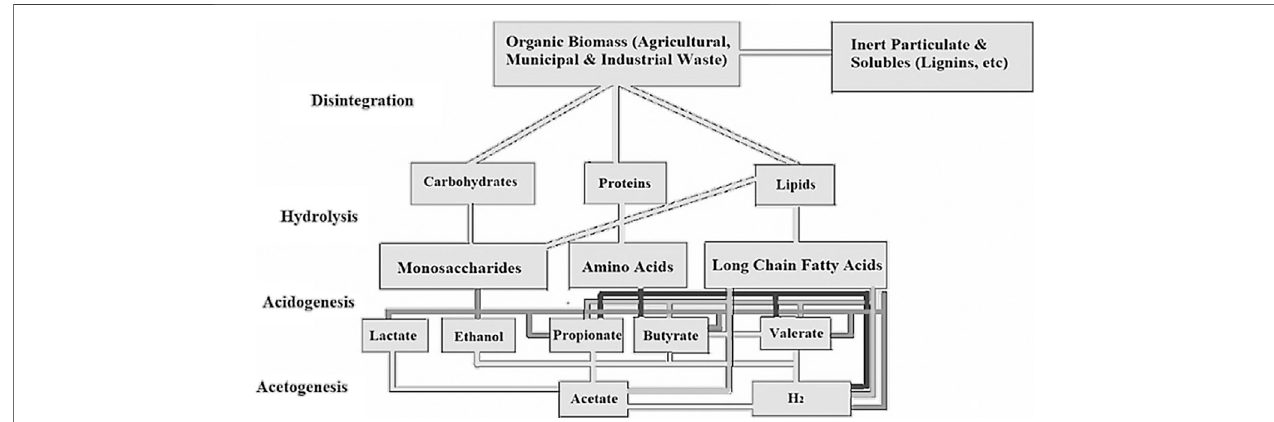
FIGURE 3 | The biochemical process of waste decomposition for biogas production (Apadted and modi fi ed after, Ghimire et al., 2015).